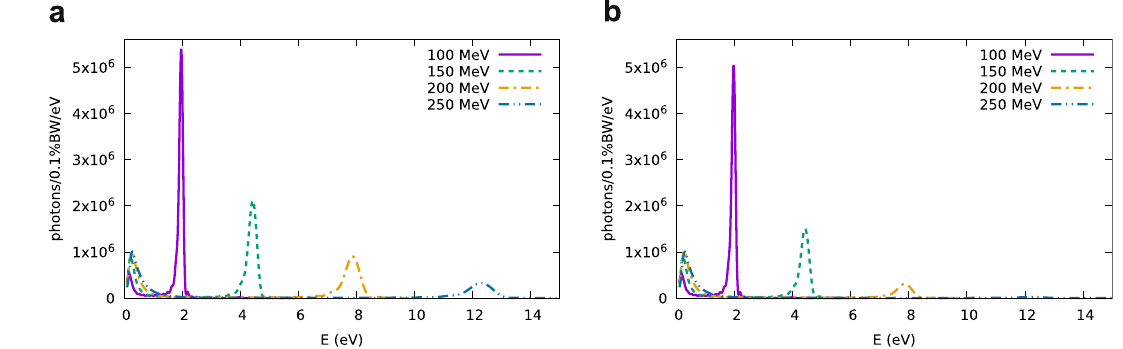
Figure 3. Sample spectra obtained for the parameters of Fig. 2, electron beam charge of 0.1 pC and r.m.s. bunch duration of ( a ) 50 as and ( b ) 100 as. Simulations carried out using SPECTRA.